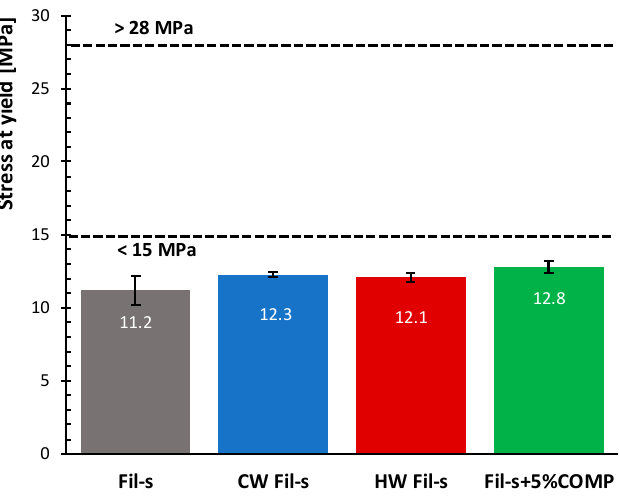
Figure 10. Comparison of the yield stress values for the analysed Fil-s based systems. The data relative to the first and last “ σ Y classes”, as defined in ASTM D3350 standard, are also reported.